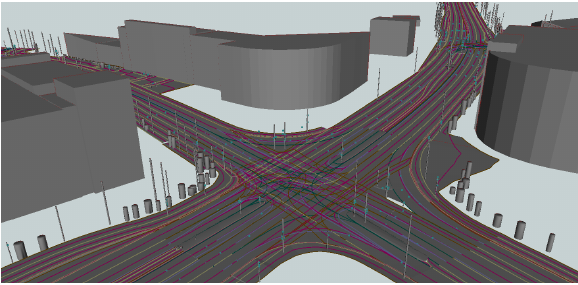
Figure 1. OpenDRIVE model of a complex intersection provided by the company 3D Mapping Solutions GmbH